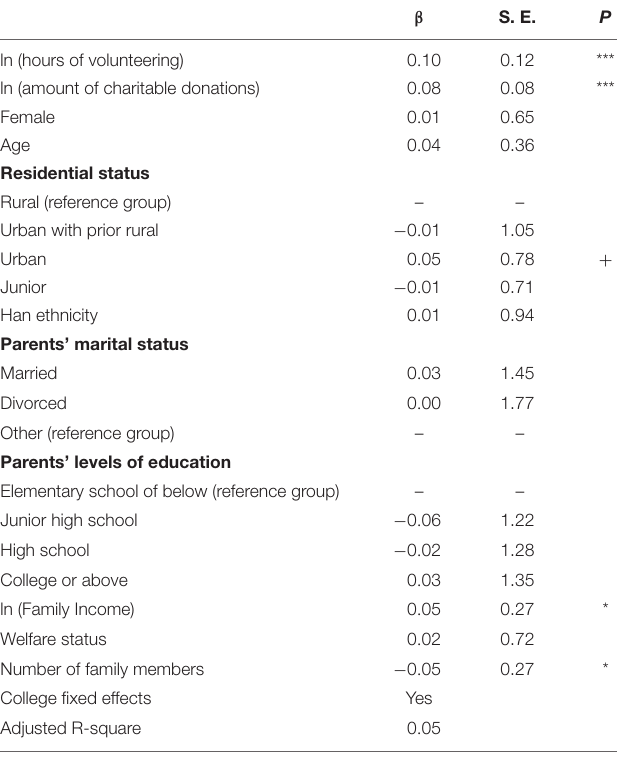
TABLE 2 | Regression analysis of psychological well-being.